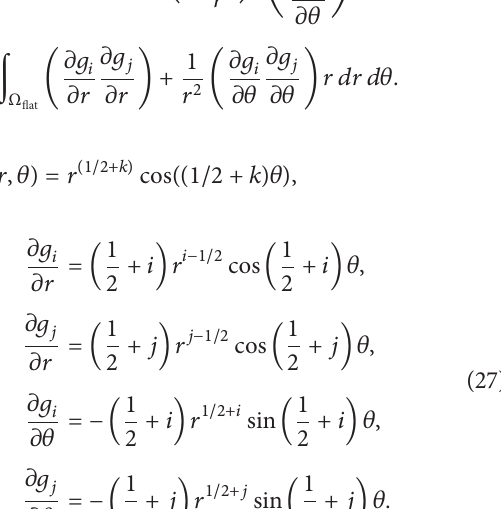
Figure 3: Shaded rectangle is the enriched patch, which is subdi- vided by disjoint regions 𝐷 and 𝐷 𝑐 for numerical